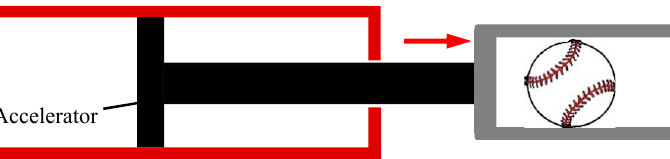
Figure 2. Setup of the pitch machine to project baseballs with desired spin rate and spin axis.